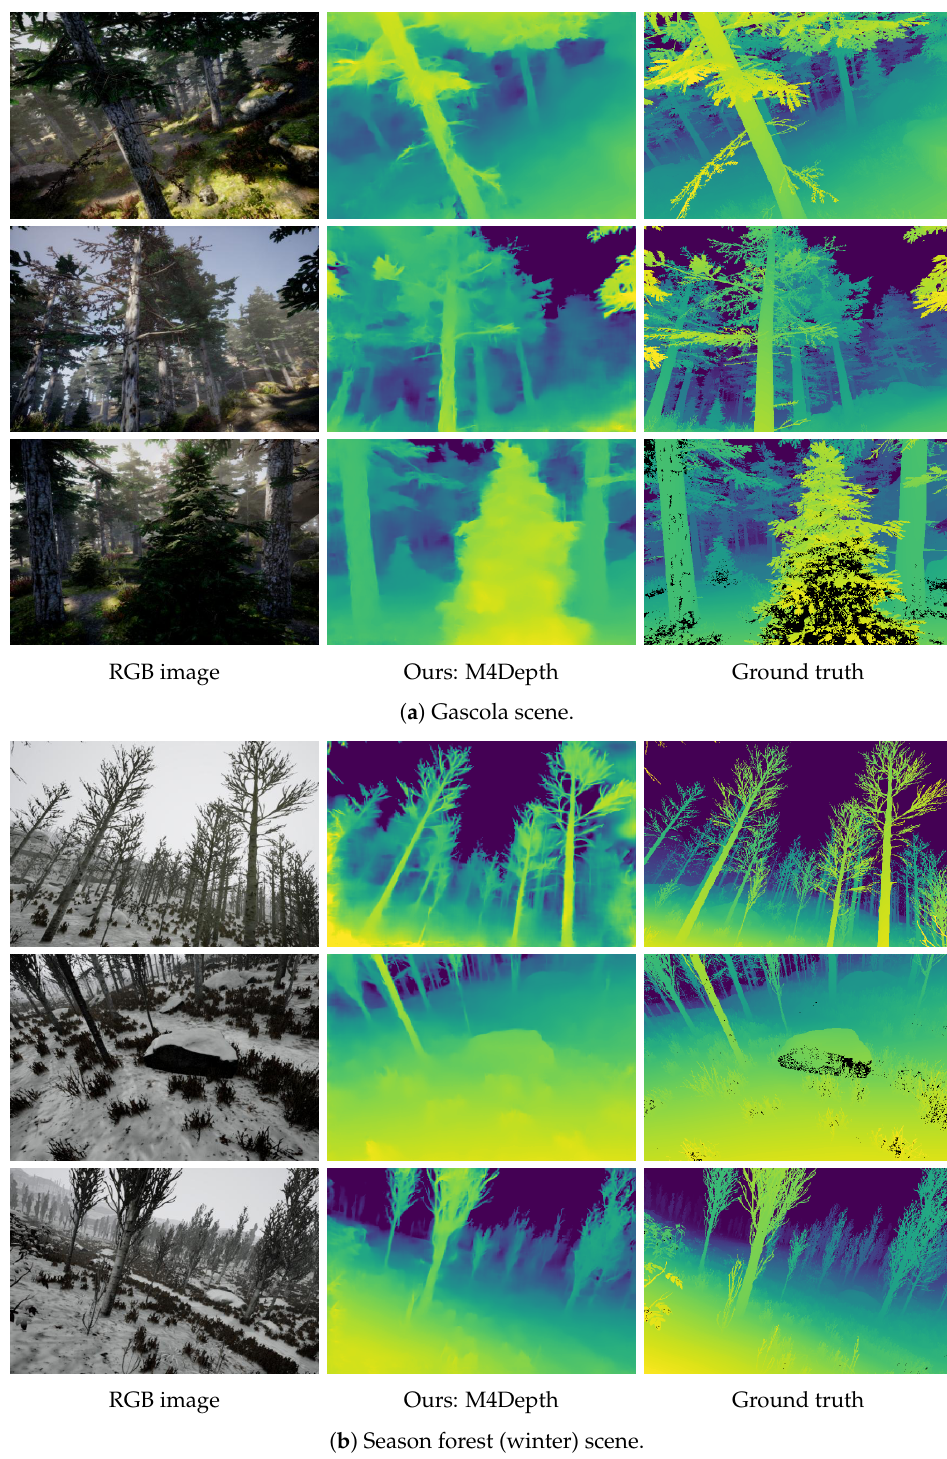
Figure 6. Samples of depth maps produced in generalization on unstructured scenes of the TartanAir dataset by M4Depth with six levels trained on Mid-Air. Black areas in the ground truths correspond to pixels with no color information in the RGB